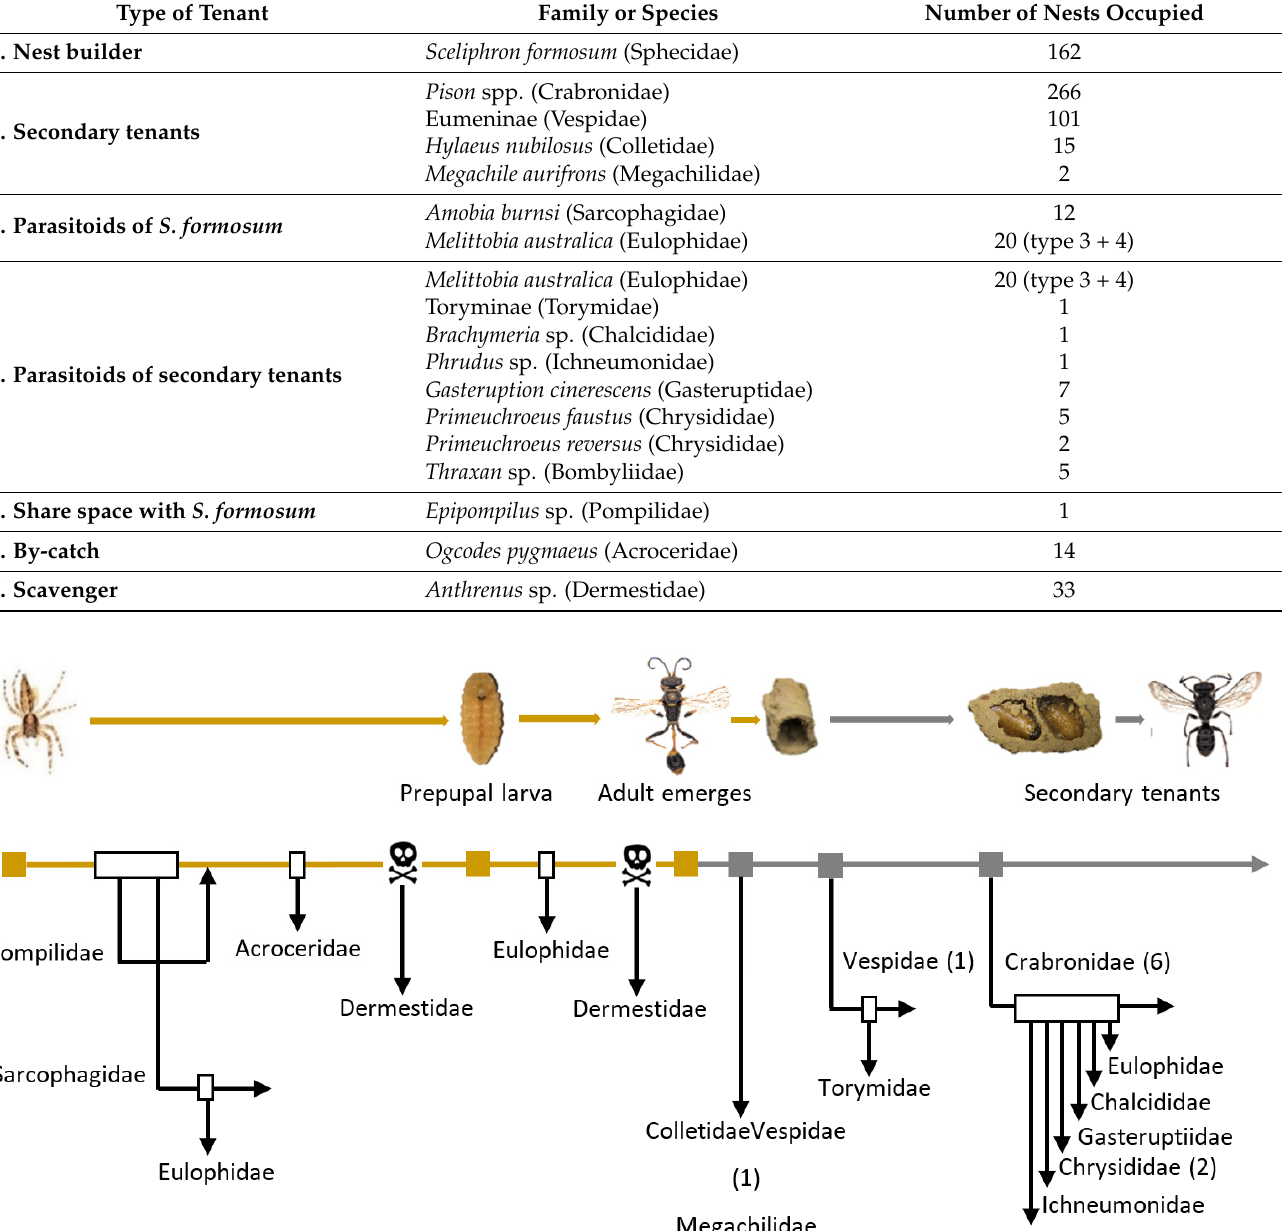
Table 3. Seven groups of insect tenants are associated with the use of mud nests.